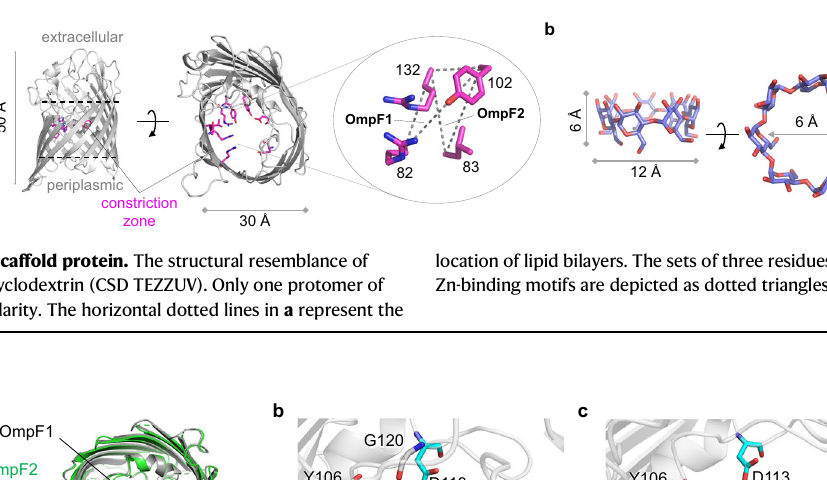
location of lipid bilayers. The sets of three residues selected for installing putative Zn-binding motifs are depicted as dotted triangles.